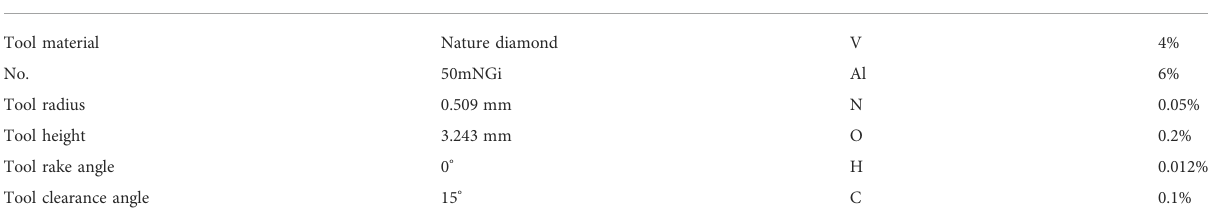
TABLE 1 Geometric parameters of the single point diamond tool and the components of the workpiece. Tool parameters Workpiece element